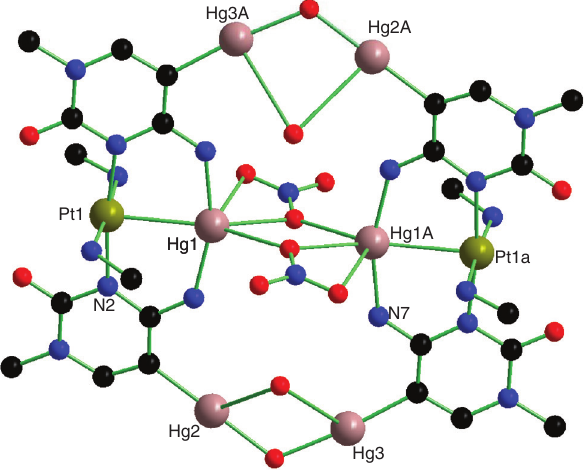
Figure 3 Simplified view of the molecular structure (diamond)